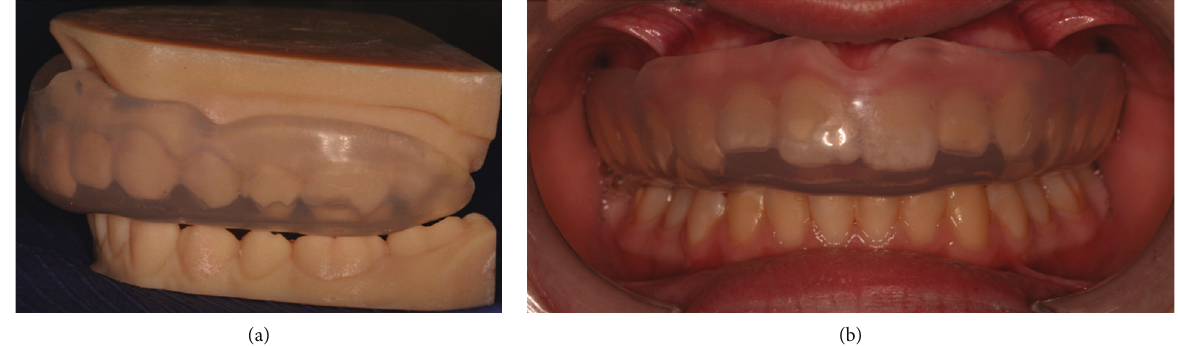
Figure 3: (a) 3D-printed dental casts with the custom-made mouthguard. (b) Intraoral picture of the mouthguard.